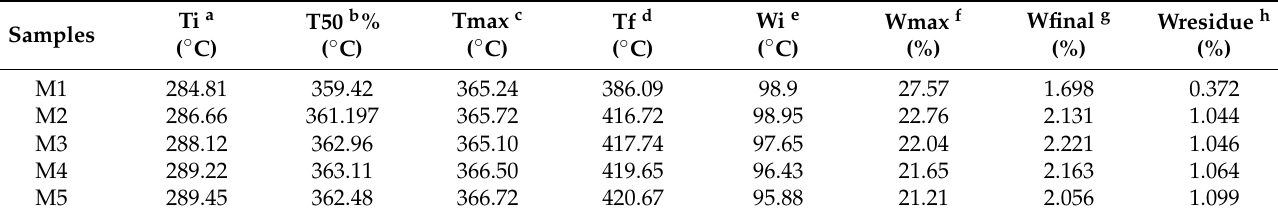
Figure 2. ( a ) TGA curves, ( b ) zoomed initial decomposition curves, ( c ) zoomed final decomposition curves of PLA-PBS-MCC composite films. Table 3. TGA results of PLA/PBS/MCC composite